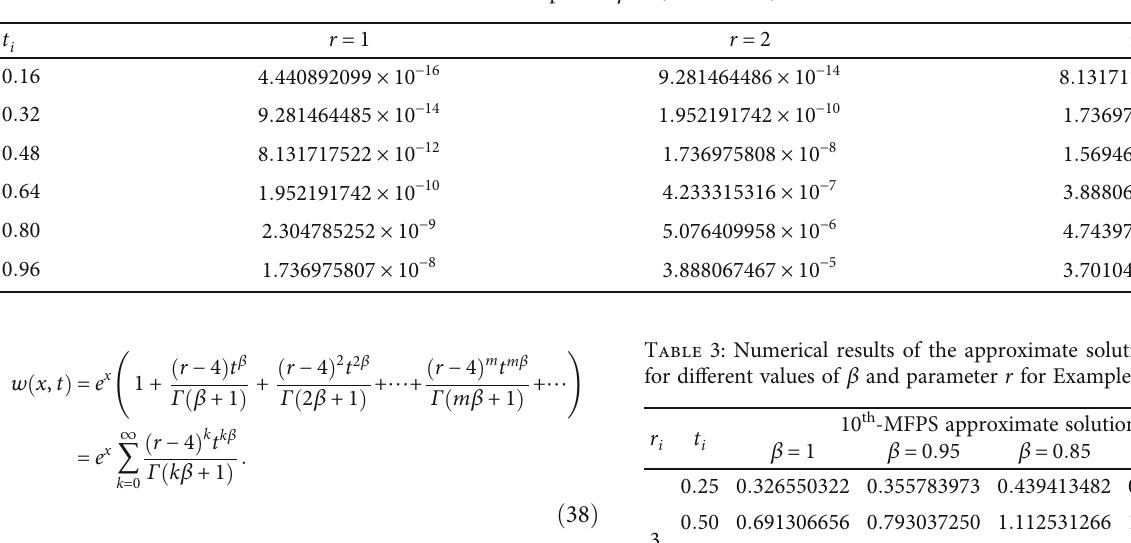
Table 2: Absolute errors for Example2 at β = 1 , and n = 10 , with di ff erent values of r .